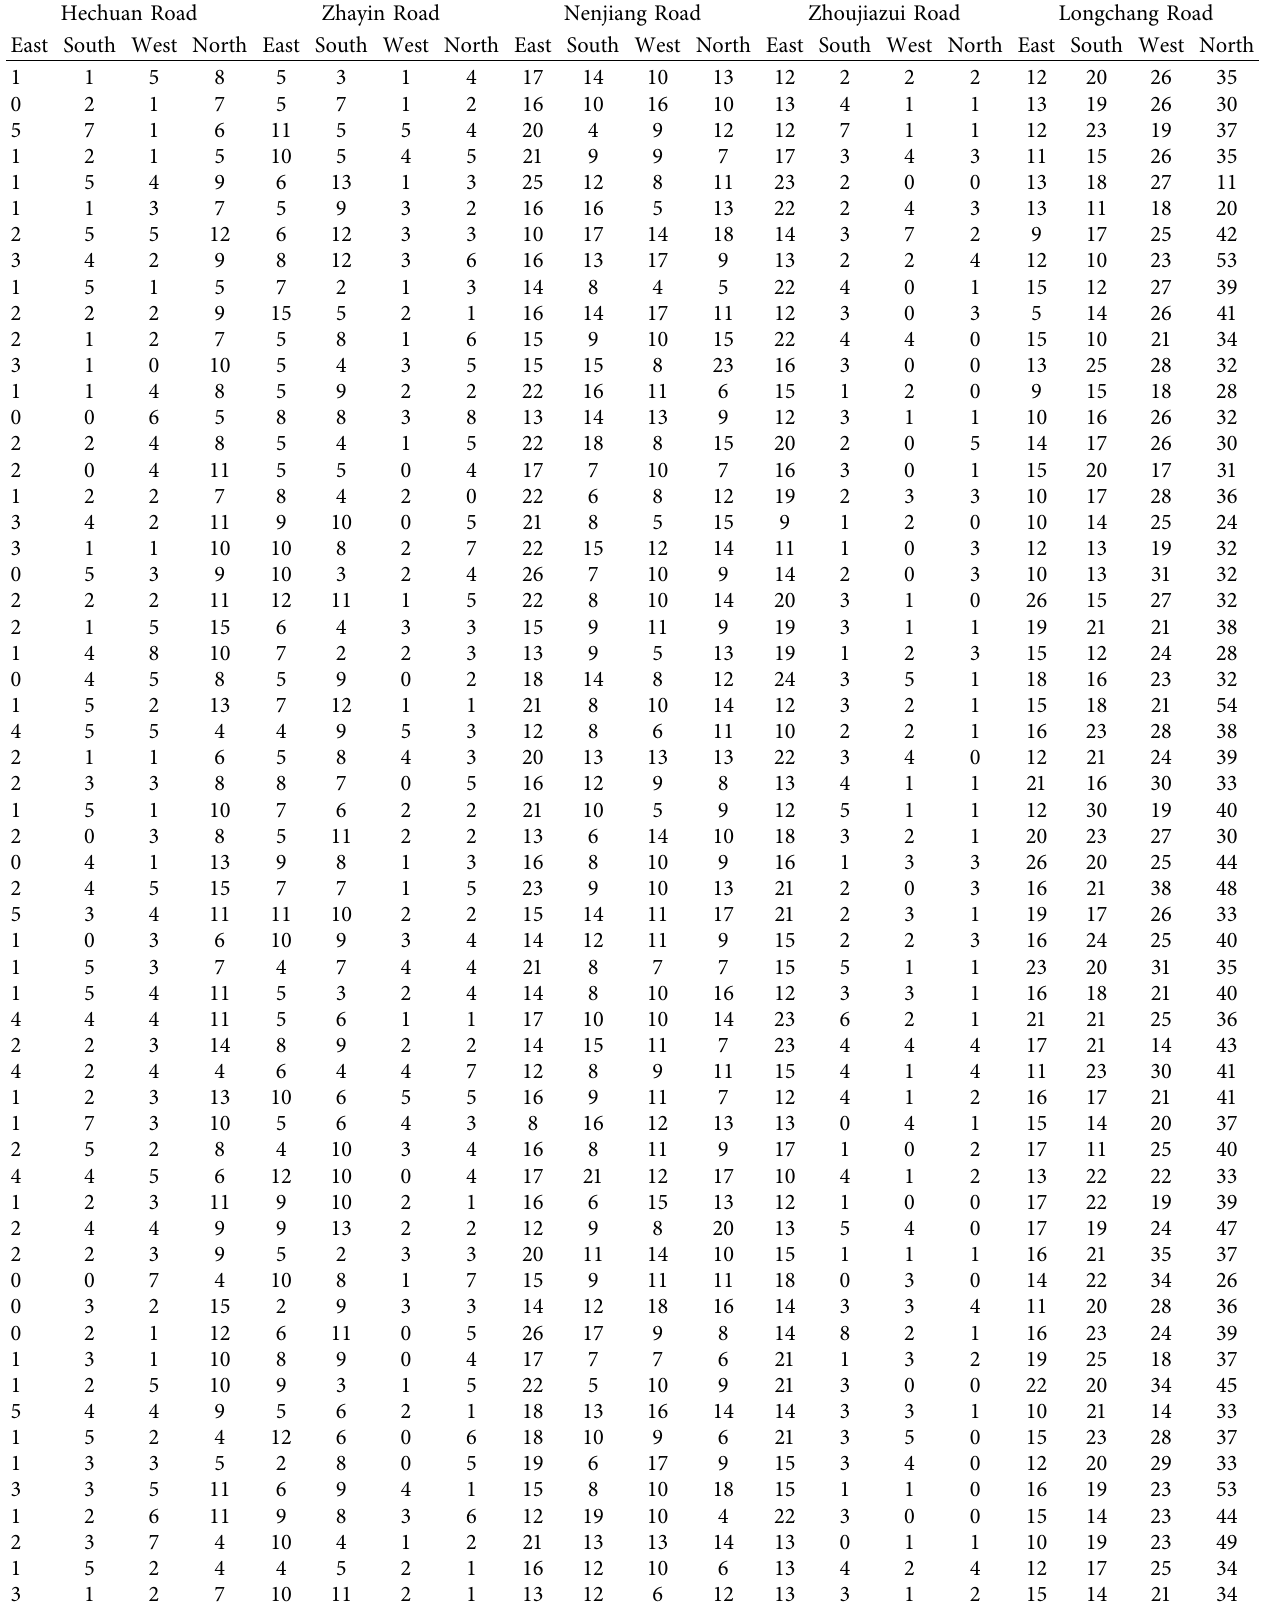
Table 7: Number of pedestrians passing in five